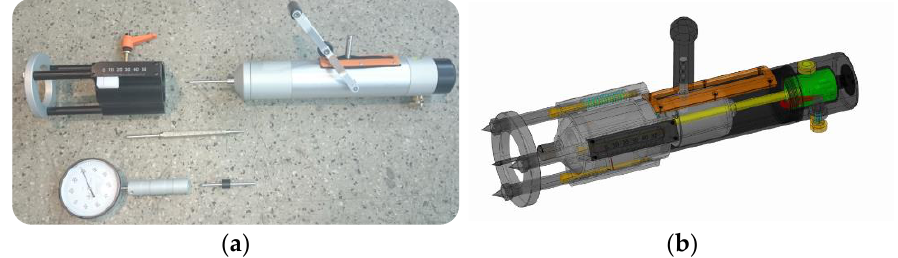
Figure 2. Impact penetrometer RSM-15: ( a ) the penetrometer full kit; ( b ) the device mechanism [29].